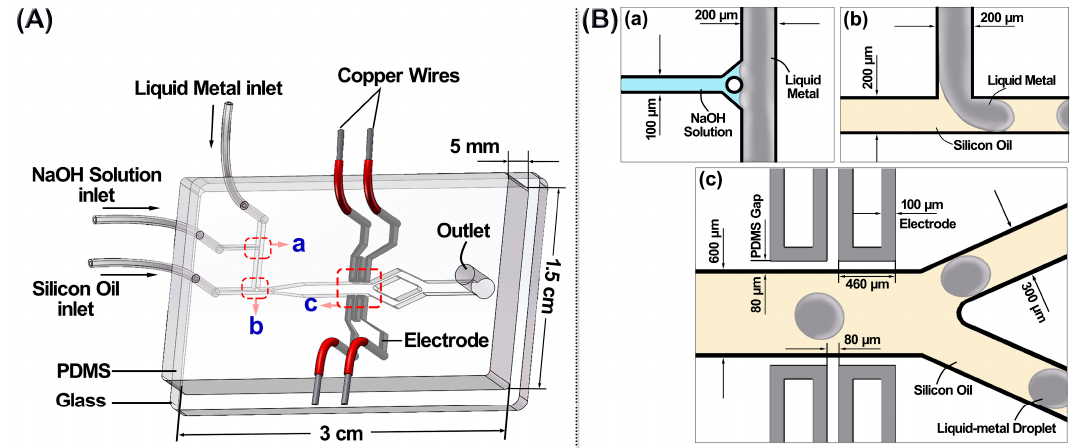
Figure 1. ( A ) Schematic view of a polydimethylsiloxane (PDMS)/glass microfluidic chip; ( B ) Zoom-in schematic of ( a ) junction of NaOH flow and liquid metal flow; ( b ) droplet generation using silicon oil as the continuous phase and deoxidized liquid metal as the dispersed phase; ( c ) Y-shape microchannel to test droplet sorting under the control of two pairs of liquid metal electrodes.